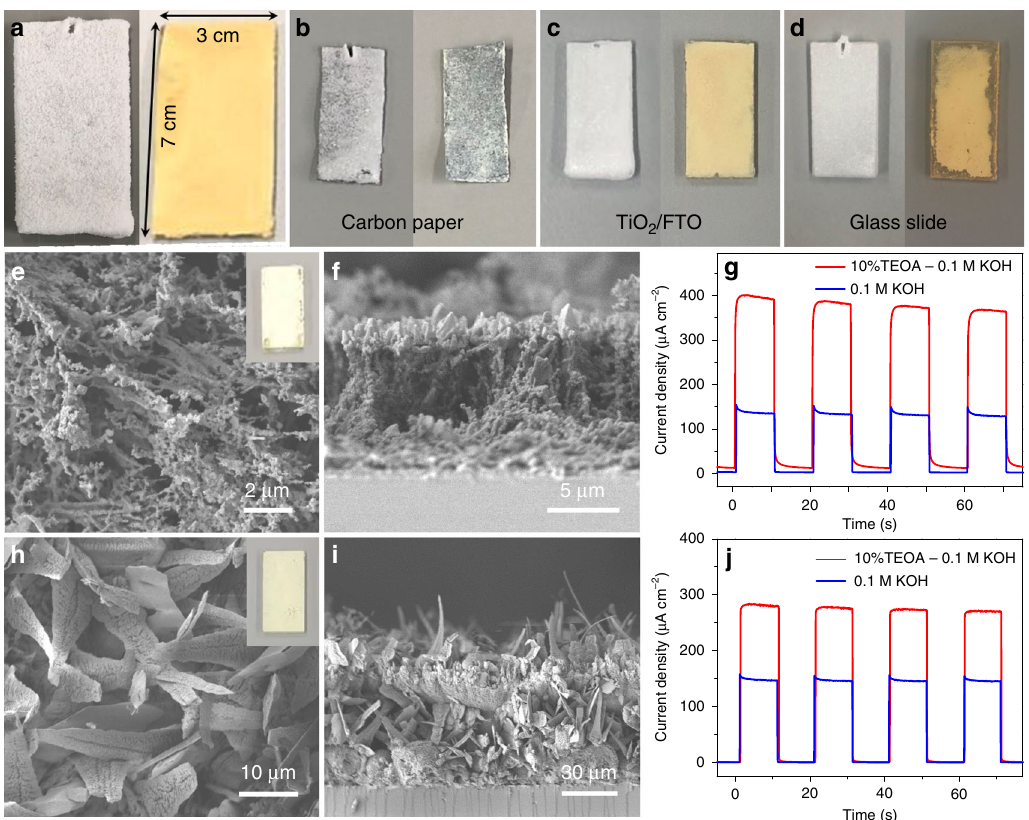
Fig. 4 Characterization of different CN fi lms. Digital images of thiourea fi lm (left) and CN T fi lm (right) on different substrates: a Large-sized FTO, b carbon paper, c TiO 2 -coated electrode, and d glass slide. e Top-view SEM image (inset: digital image of CN U electrode) and f cross-sectional SEM image of CN U fi lm on FTO. g Photocurrent density curves (chronoamperometry) of CN U electrode at 1.23 V vs. RHE. h Top-view SEM image (inset: digital image of CN D electrode) and i cross-sectional SEM image of CN D fi lm on FTO. j Photocurrent density curves (chronoamperometry) of CN D electrode at 1.23 V vs.